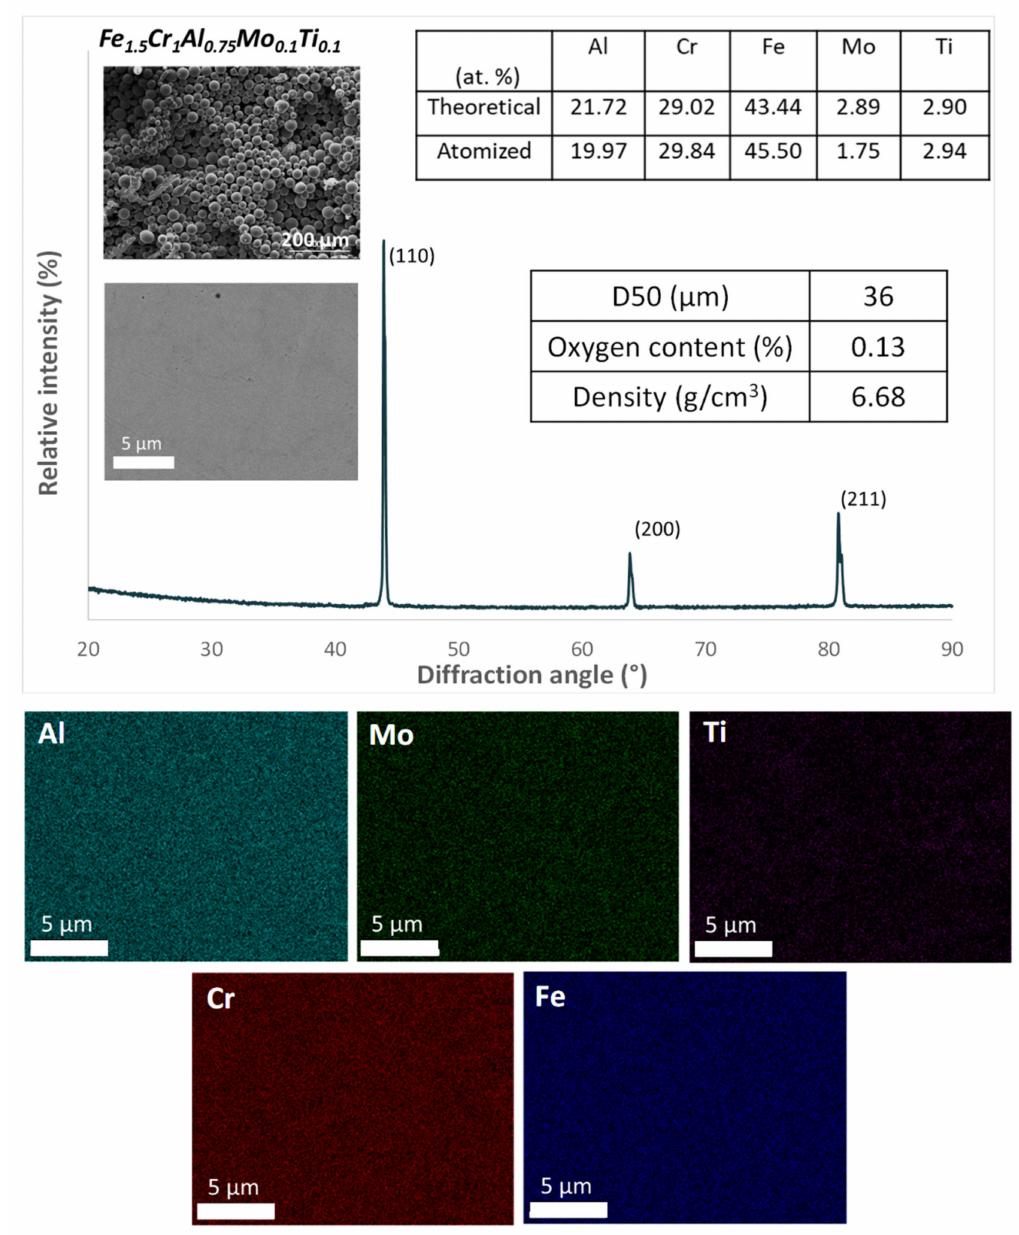
Figure 1. Results of the characterization of FeCrAlMoTi atomized powders: the XRD spectra elemental composition, morphology, density, particle size, and oxygen